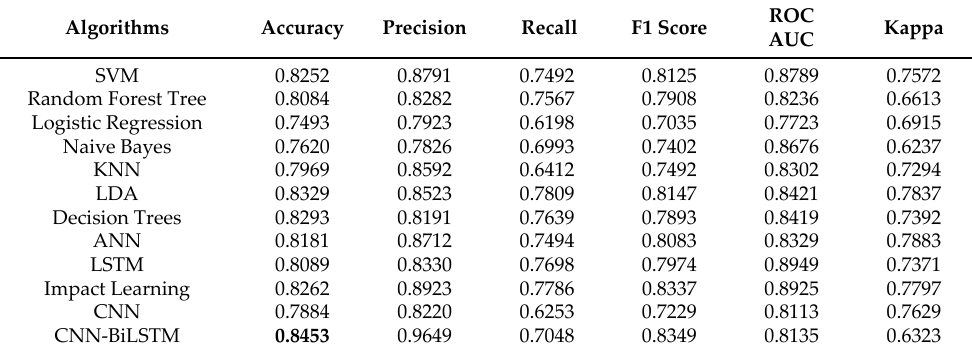
Table 5. Performance of